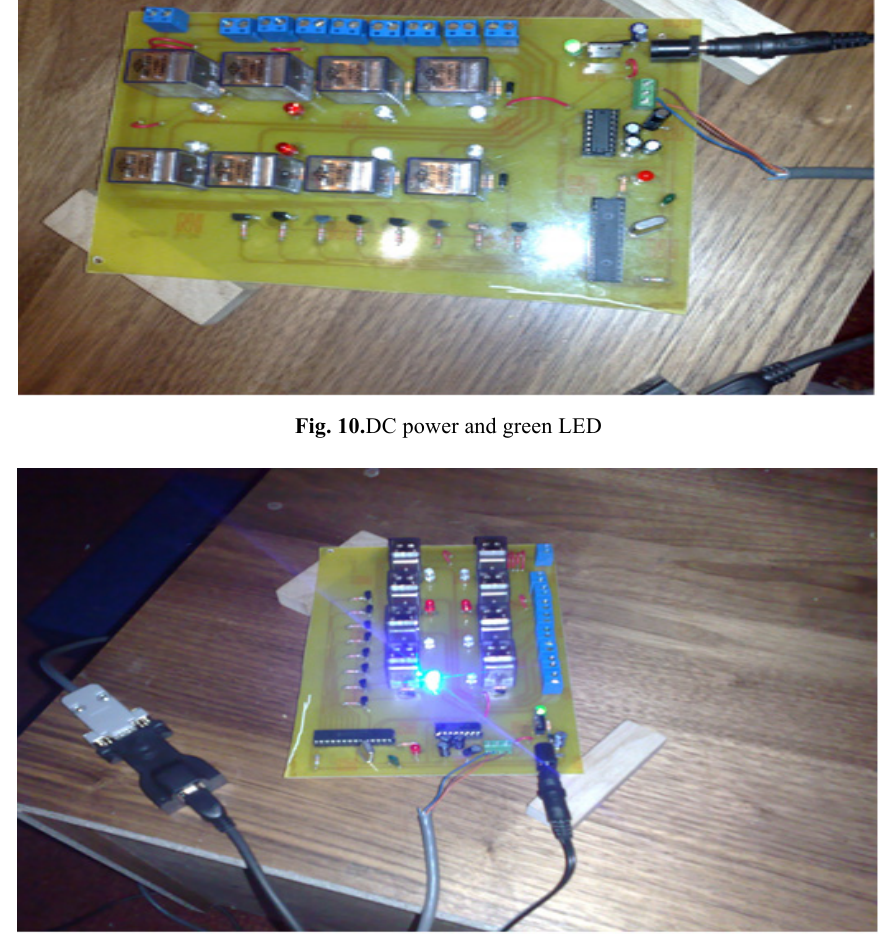
Fig. 11. Relay 1 (LED